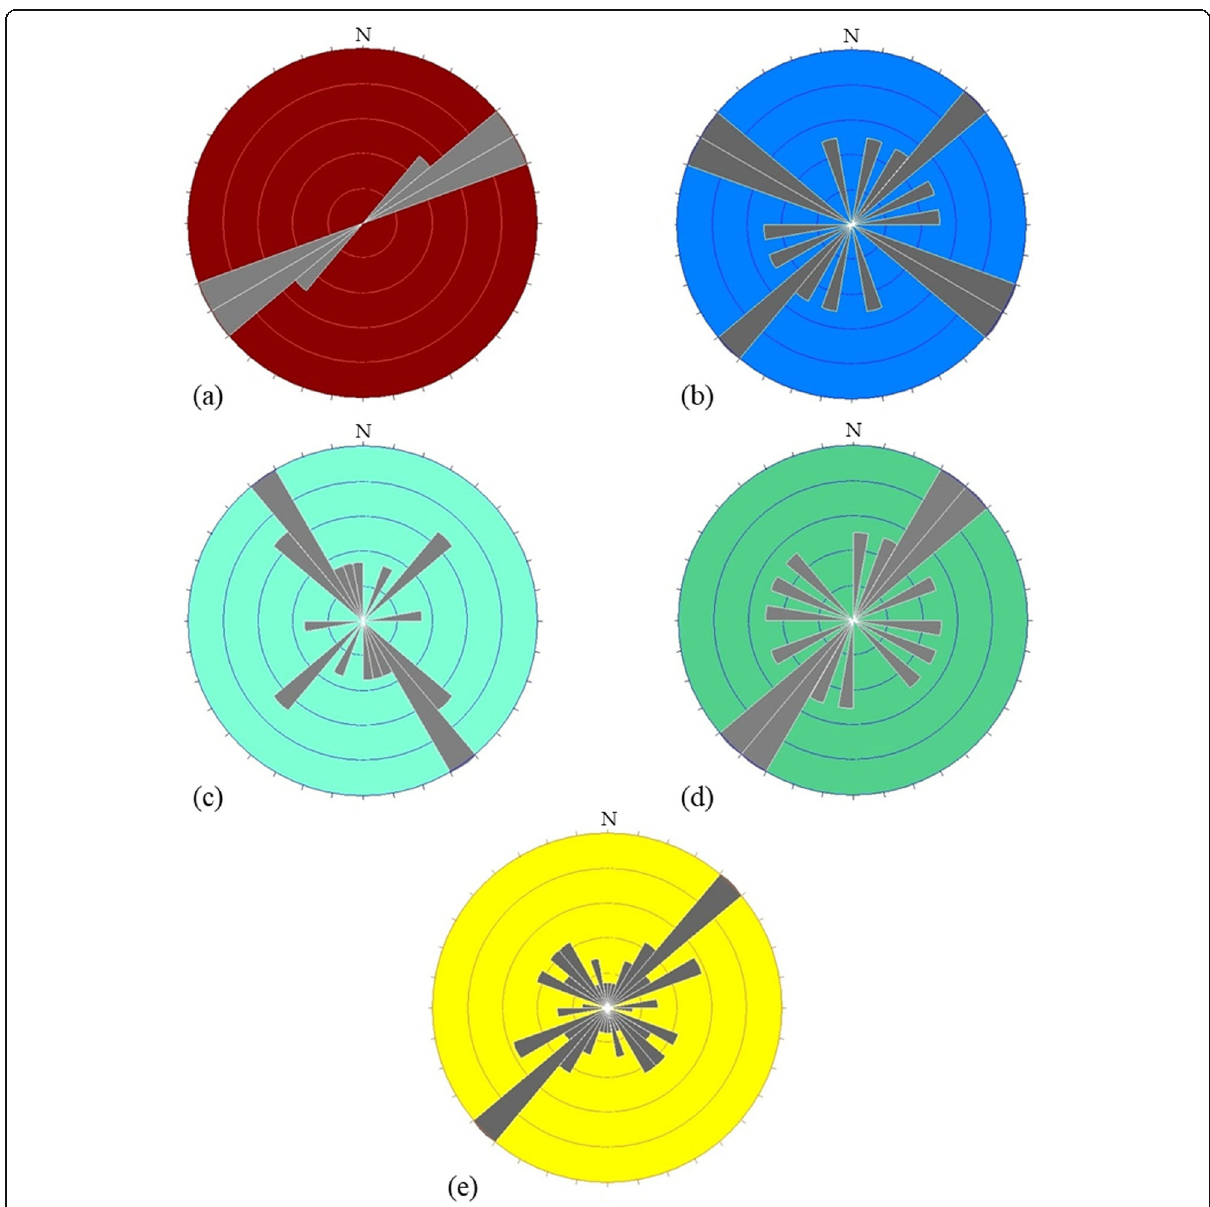
Fig. 7 Rose Diagrams of ( a ) Andesite unit; b Crystalline limestone unit; c Fragmental limestone unit; d Reefal limestone unit; and e all